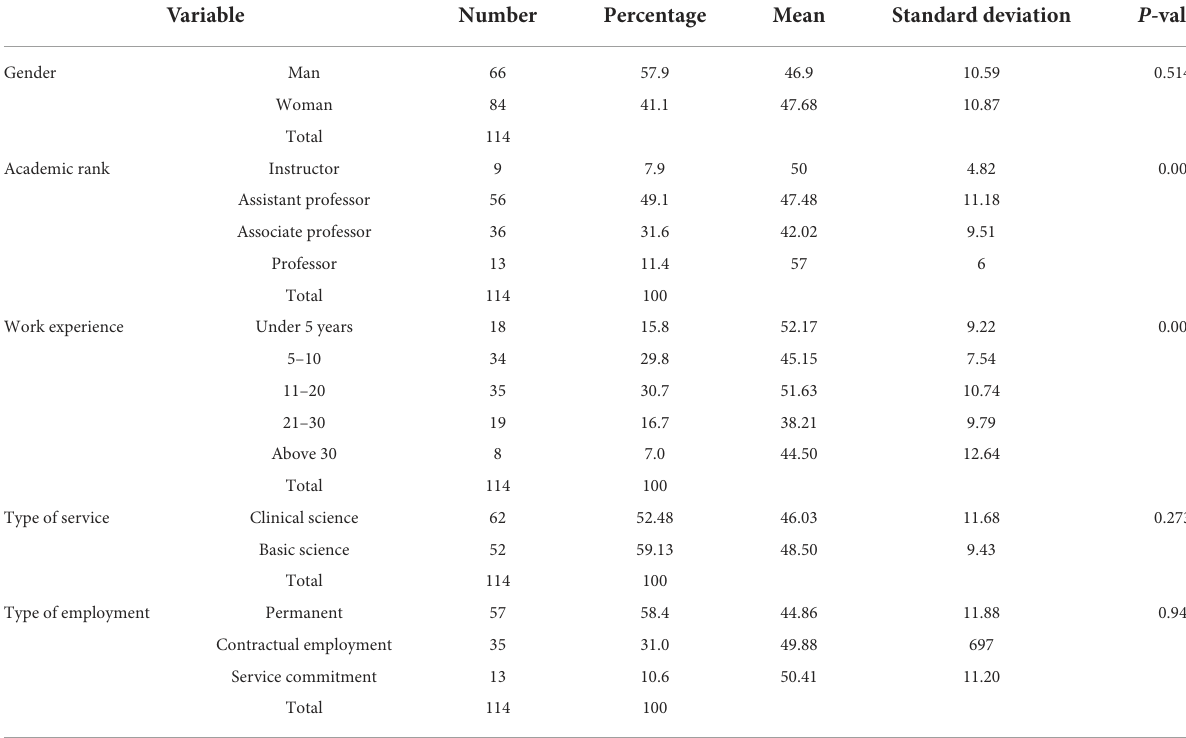
TABLE 1 Effect of M-Learning and the designed App in promoting the awareness of faculty members. Variable Number Percentage Mean Standard deviation P